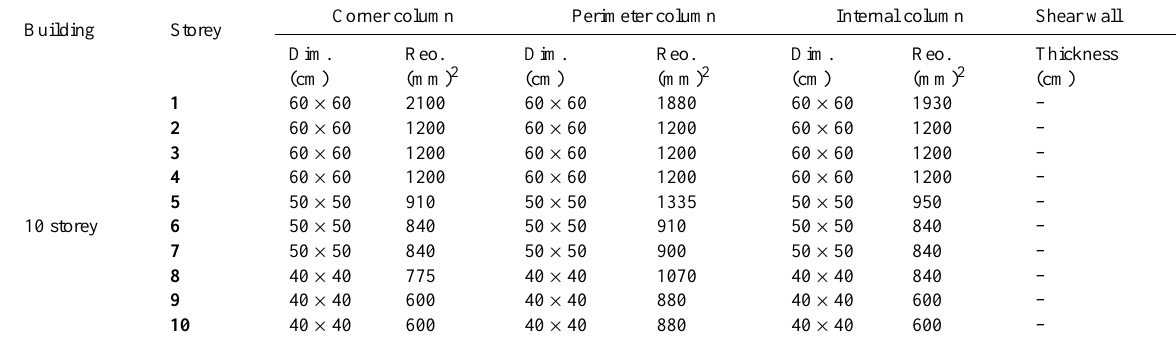
Table 2. Dimensions and amount of reinforcement of beams in 10 storey-building. Beams of external frames Beams of internal frames Type Storey